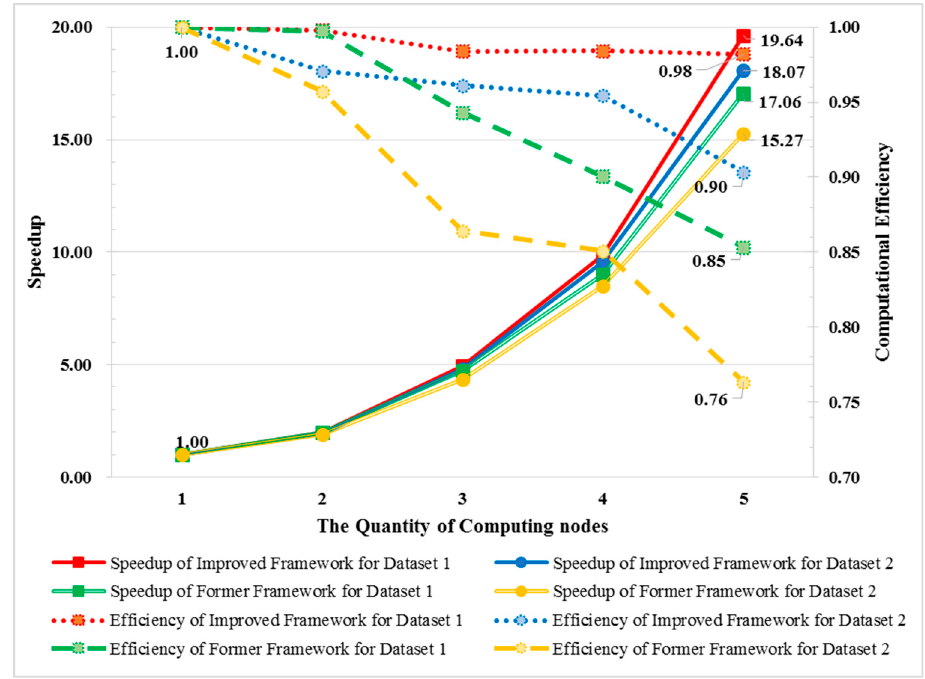
Figure 8 The speedup and computational efficiency of the improved MA-based ABC framework. Figure 8. The speedup and computational e ffi ciency of the improved MA-based ABC